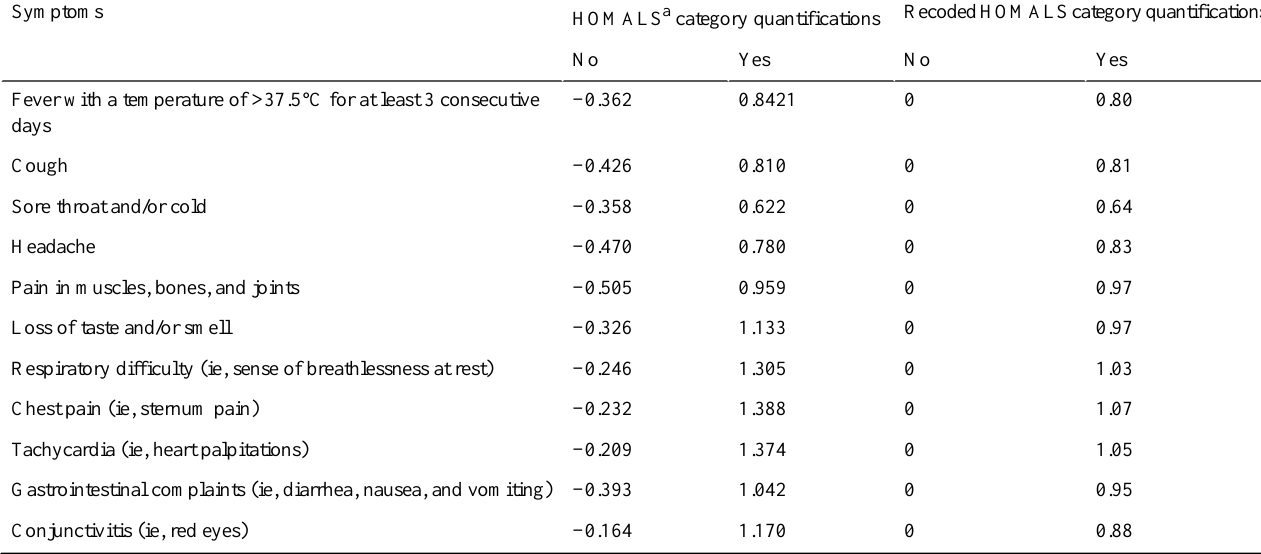
Table 3. Multiple correspondence analysis optimal weights for the recoding of the EPICOVID19 diagnostic scale.